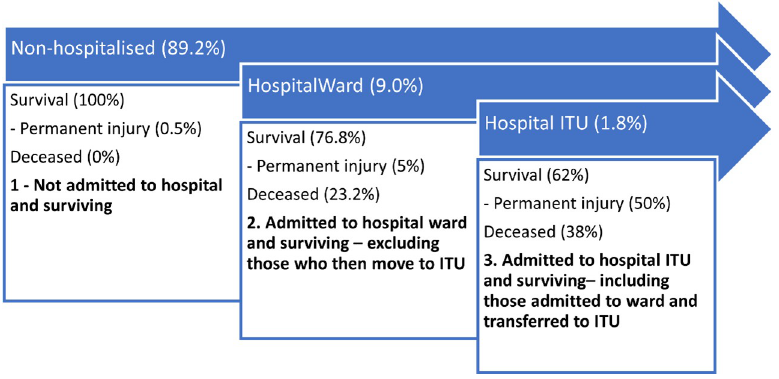
Fig 1. The pathways of care for the three survivor compartments amongst symptomatic